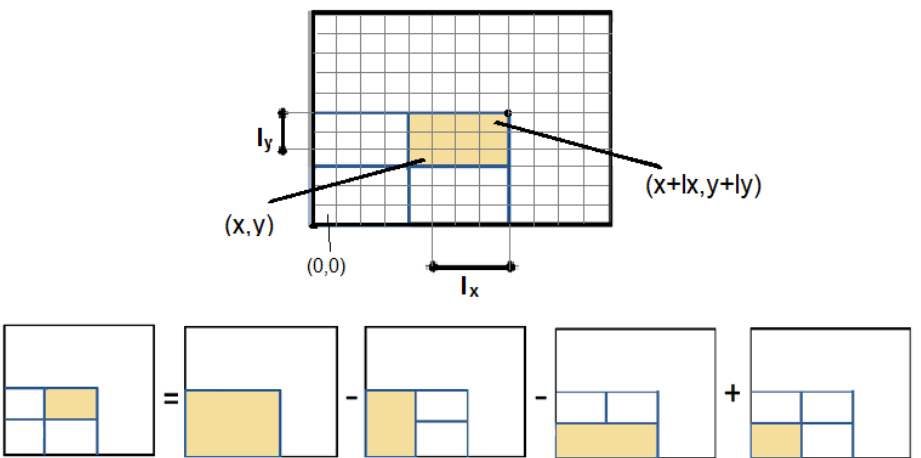
Figure 3. Once the Integral Image is constructed, the sum of any rectangular area is calculated in constant